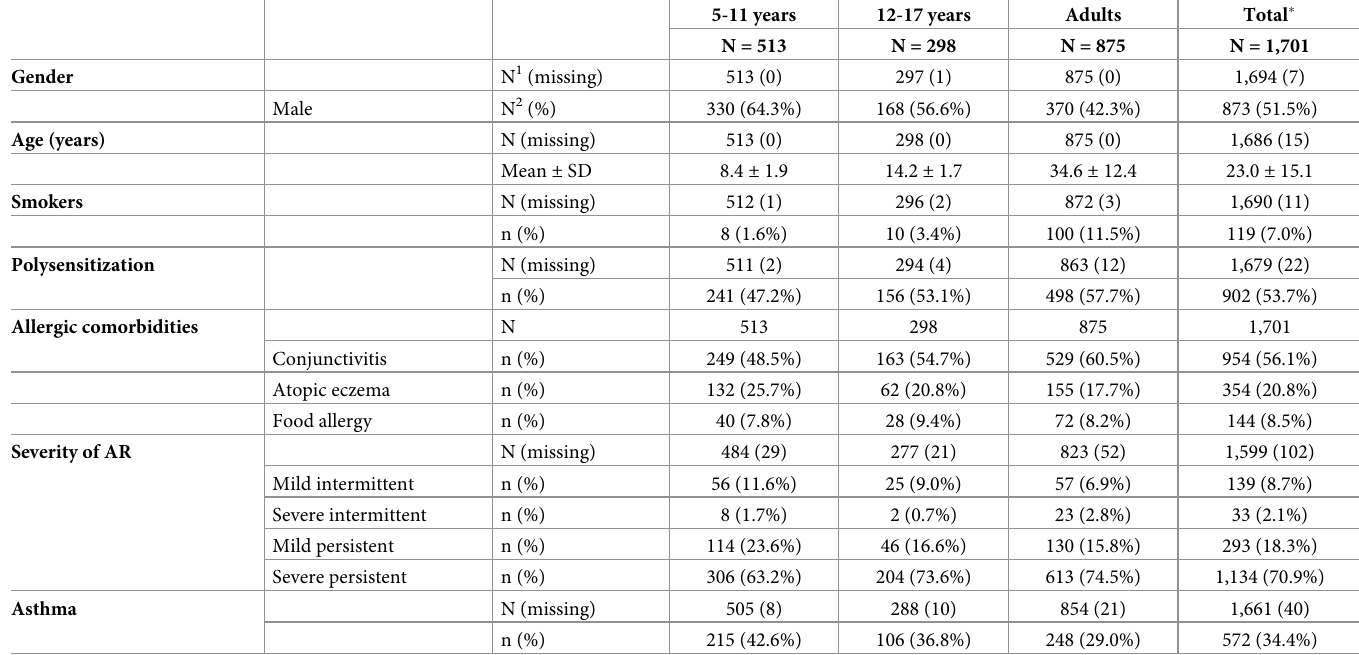
Table 1. Characteristics of study population.